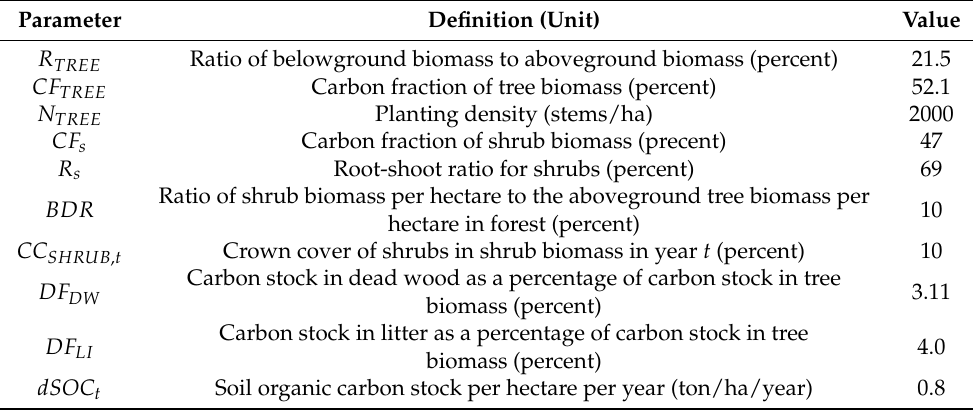
Table A2. Parameters used for carbon stock measurement in larch at the study site.